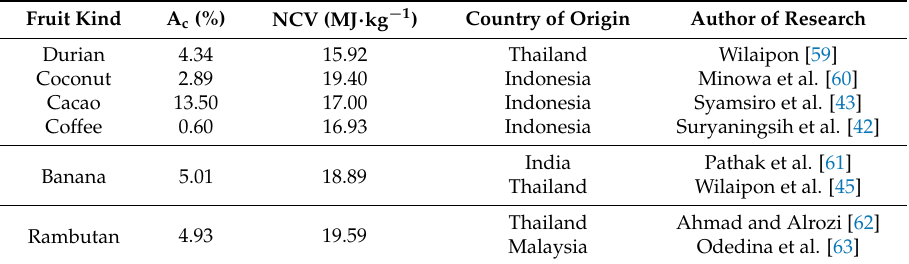
Table 6. Energy potential of fruit waste biomass kinds proved by other authors.